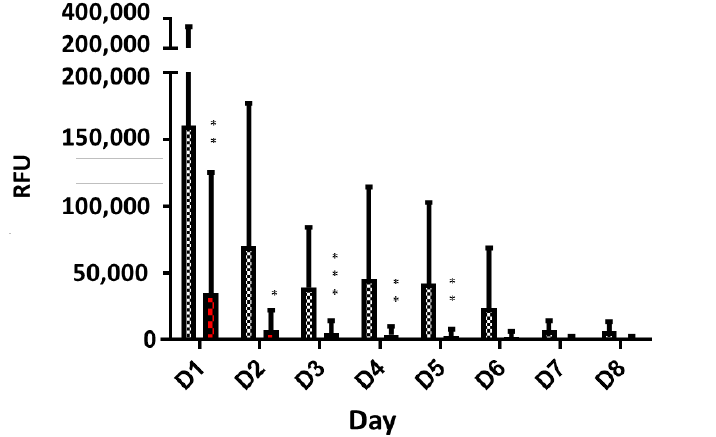
Figure 5. Adenosine triphosphate (ATP) assay for determining bacterial growth in patient wound in contact with chitosan and regular gauze dressings for 8 d post-surgery (RFU = relative fluorescence units, * p < 0.05, ** p < 0.01, *** p < 0.001).